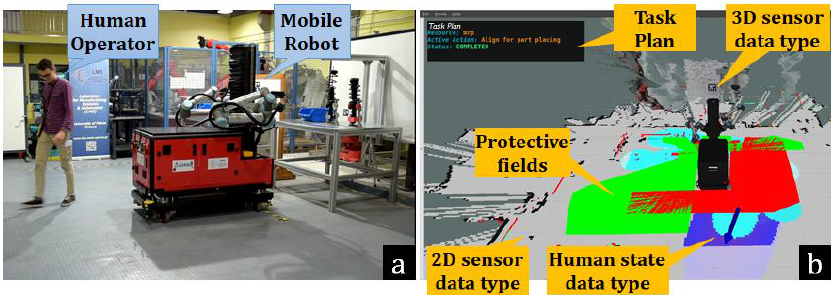
Figure 12. Automotive pilot cell ( a ) real world, ( b ) 3D planning scene.